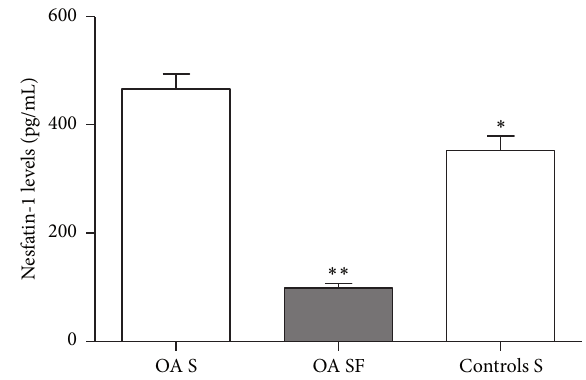
Figure 1: Nesfatin-1 gene expression in five OA-affected articular tissues. All the five OA affected cartilage, osteophytes, synovium, meniscus, and fat pad have nesfatin-1 gene expression.